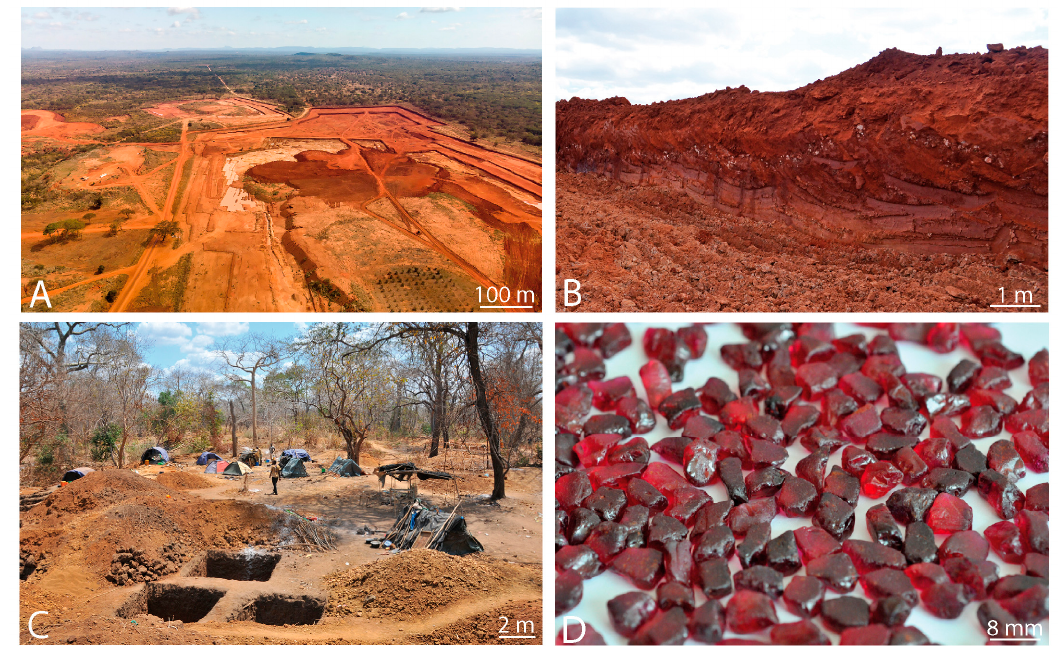
Figure 54. The placer deposits in the Montepuez mining district in Mozambique. ( A ) Aerial view of the Mugloto Pit operated by the Gemfields Group Ltd. The miners are using a back-filling technique (top) and using tree plantations for rehabilitation (bottom); ( B ) the ruby-rich gravel layer at Mugloto in the Montepuez mining district. The detritic levels contain sub-angular quartz and clay pebbles located between 4 and 10 m under the surface. Gemfields removes the overburden and uses an excavator to collect this gravel layer, that is then sent to the wash plant to extract rubies; ( C ) small scale miners near Nacaca village, an area reserved for locals outside the southeast border of the Gemfields concession, where a few thousand people have worked since 2012. At this location small rubies are found in gravels under to 2–5 m of overburden. The Nacaca stones are usually smaller and contain more inclusions than those from Mugloto and their iron content is similar to that of the material from Maninge Nice; ( D ) parcel of rough rubies from Mugloto Pit near Montepuez (about 0.5 g per stone) at a Gemfields rough ruby auction in Singapore. The rubies coming from a gravel layer range from bright to dark red (depending on their iron contents), and present some abrasion features. The area was discovered in early 2014 and probably more than 90% of Gemfields income since then has been extracted from this deposit. Photo: Vincent Pardieu © GIA.